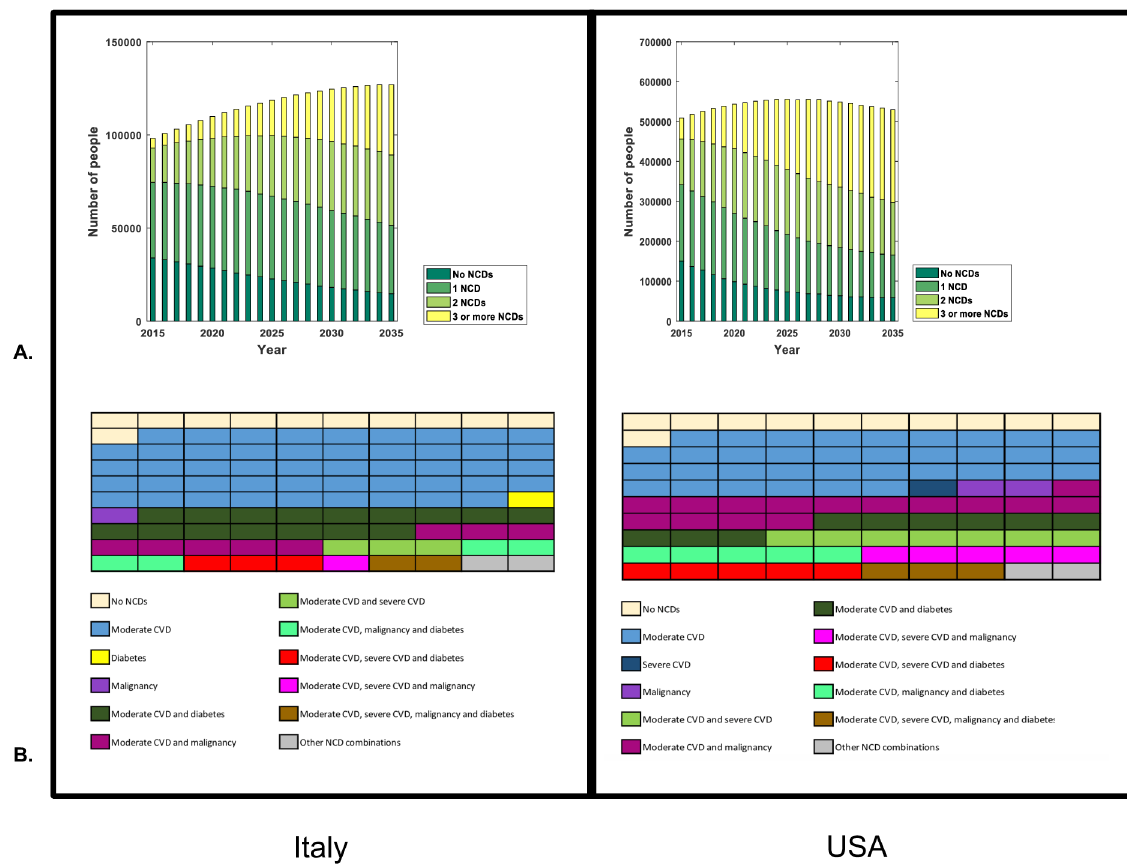
Fig 3. The predicted change in non-communicable disease burden. A. The numberof HIV-positivepatientson antiretroviral therapywith 0,1, 2 or 3 and more non-communicablediseasesbetween2015and 2035in Italy and USA. Note : the two graphsare not on the same axis . B . The predictedco-morbiditiesprofilesamongstHIV-positivepatients on antiretroviraltherapyin 2035based on a cross-section of 100 patients(eachsquarerepresentsone patient)for Italy and the USA. Abbreviations : Cardiovascular disease (CVD) , Chronickidneydisease(CKD) , Moderate CVD (dyslipidemia and/orhypertension) and SevereCVD (MI or stroke); United States of America (USA) .